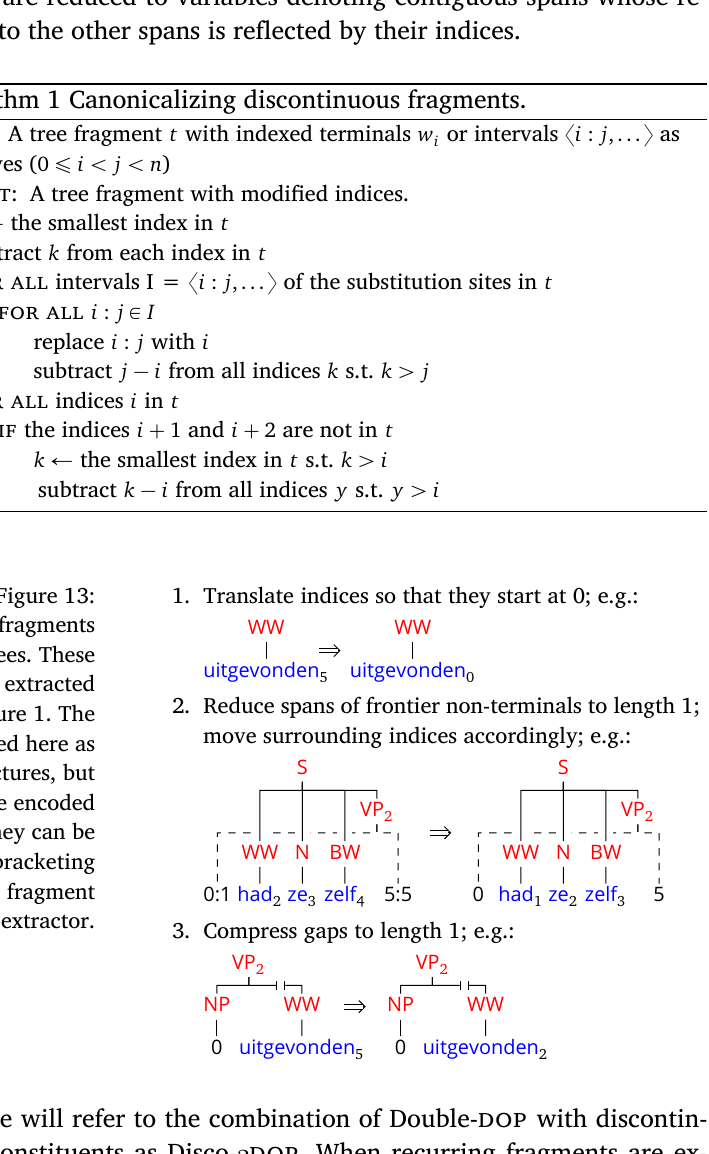
Algorithm 1 Canonicalizing discontinuous fragments.